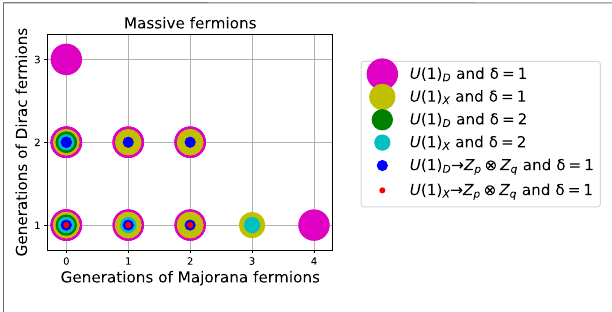
FIGURE 3 | Same as Figure 2 but for number generations of massive Dirac and Majorana fermions of the full set of solutions in Figure 1 .